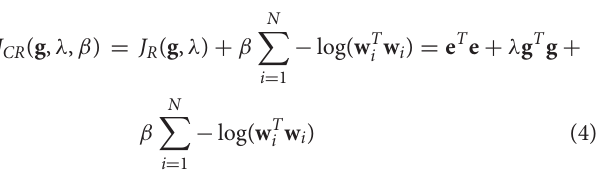
algorithm constructs an RBF network using the training data